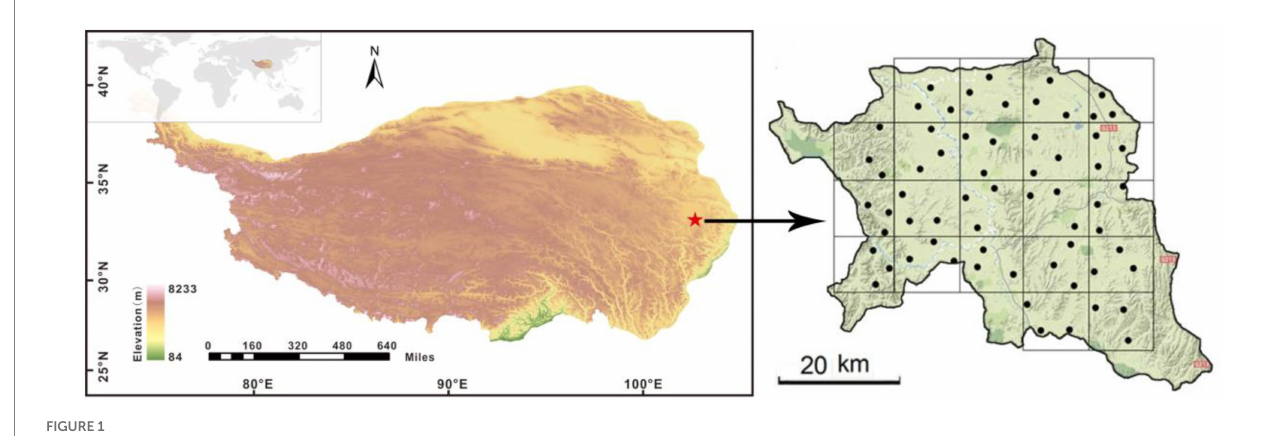
FIGURE 1 Distribution of the sampling